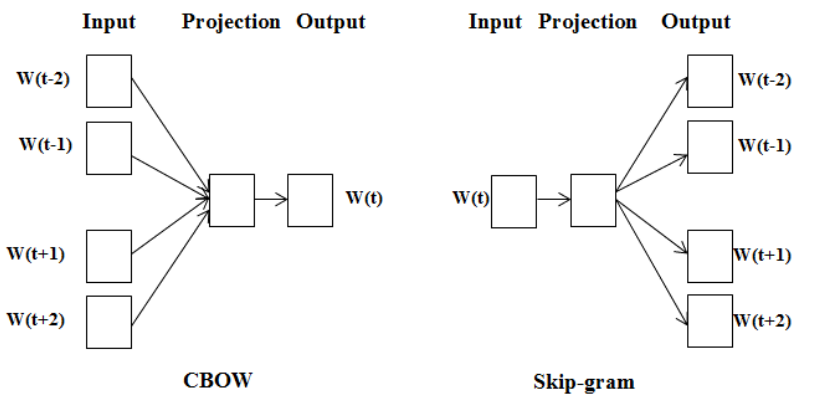
Figure 4. CBOW and Skip − Gram